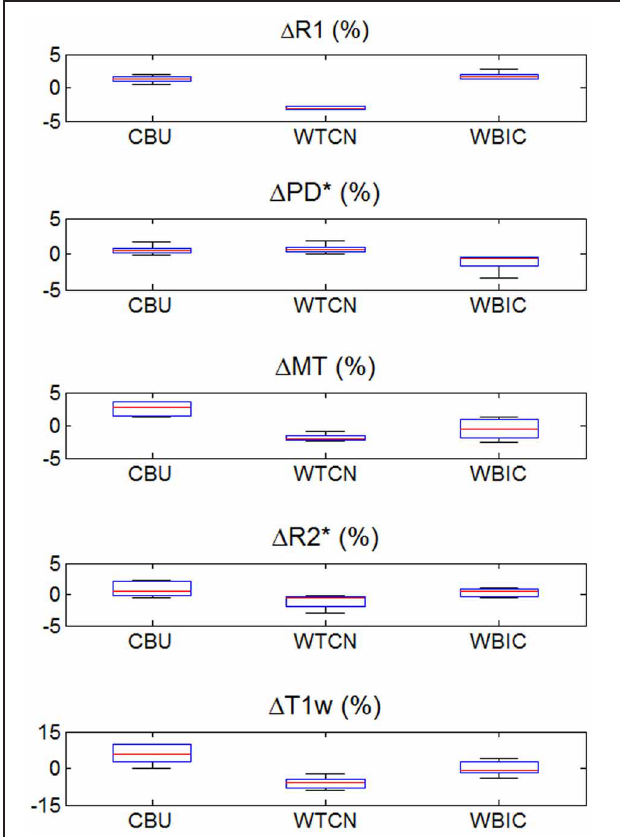
FIGURE 4 | Inter-site bias of R1, PD ∗ , MT, and R2 ∗ parameter and T1w image intensity values in gray and white matter for the three different sites (except for PD ∗ , which was assessed in gray matter only). To enhance visibility of any potential inter-site bias, the percent deviation from the mean across sites is shown and plotted for all volunteers. For description of the whisker plot, see Figure 2 .